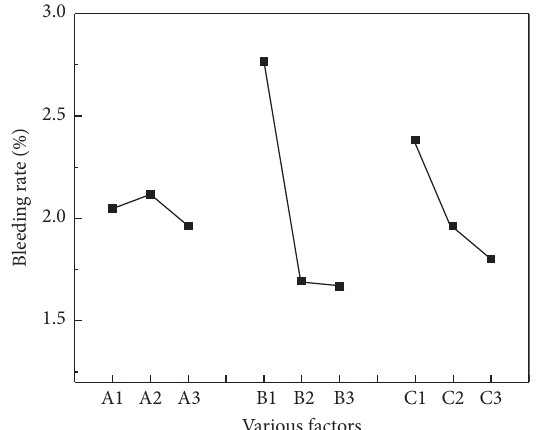
Figure 7: The tendency of bleeding ratio and factor level of paste filling.